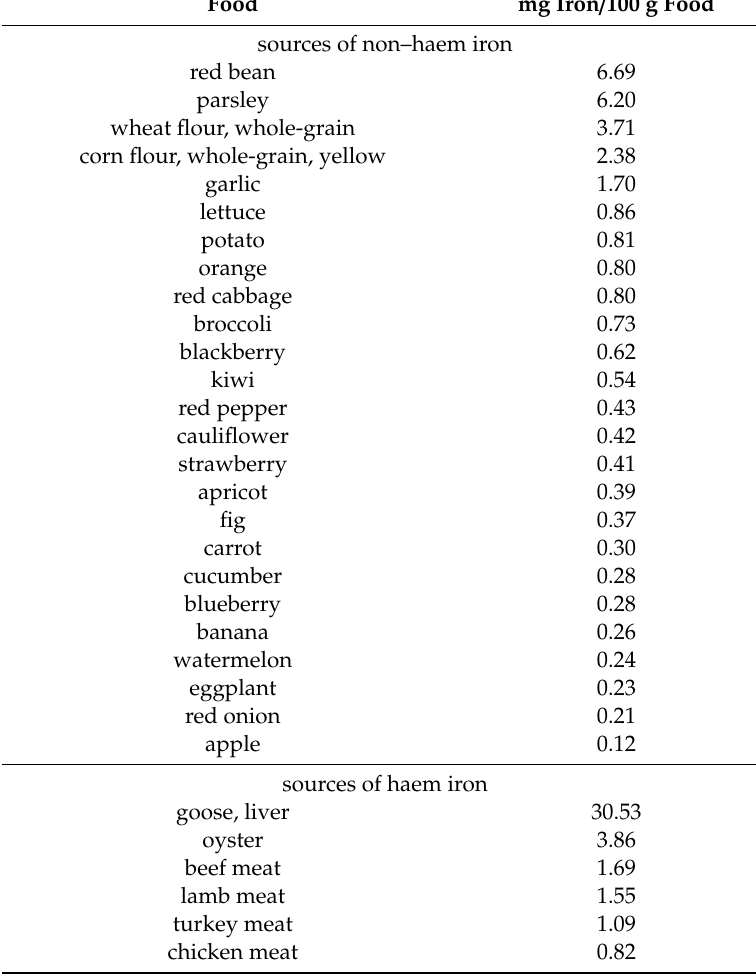
Table 2. Amount of total iron in common foods